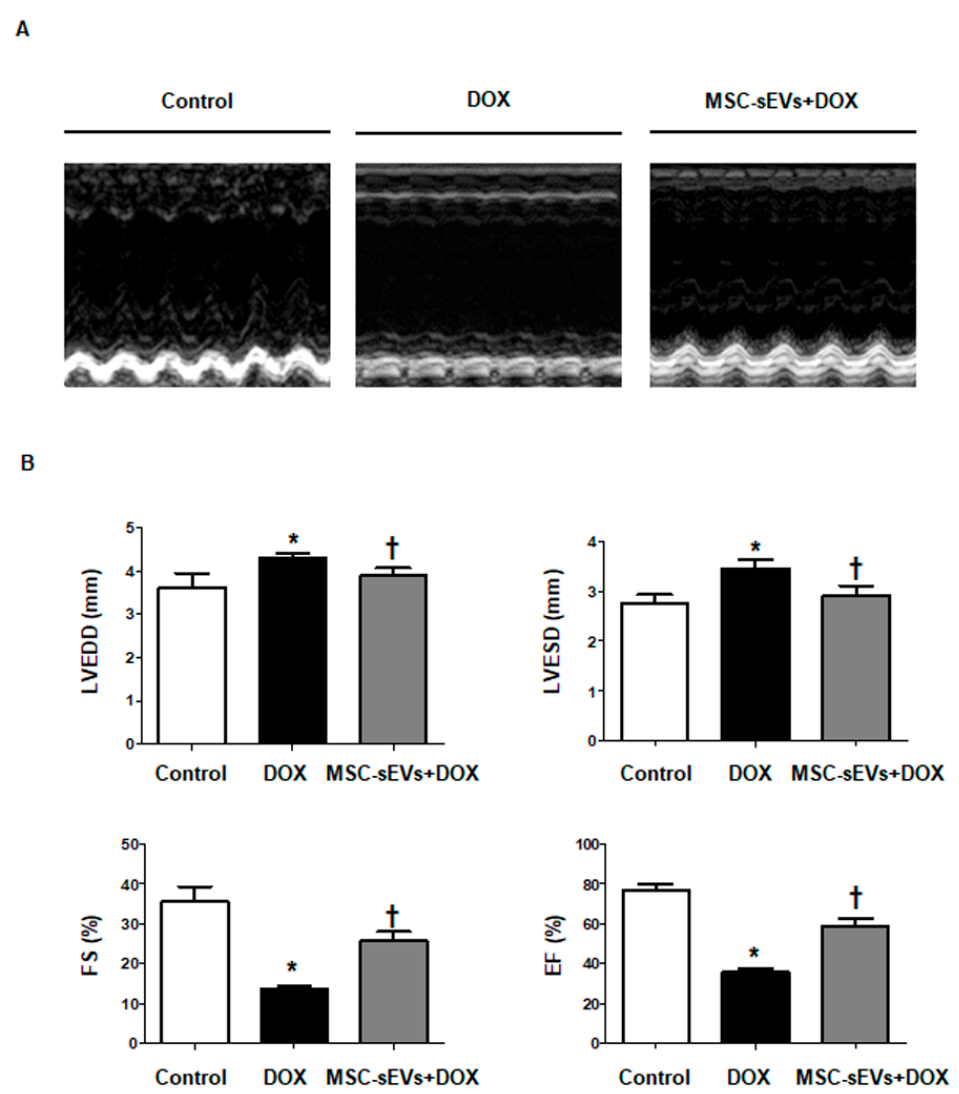
Figure 8. MSC-sEVs improves acute DOX − induced cardiomyopathy in an in vivo mouse model. ( A ) Representative M − mode images from the control, DOX, and MSC-sEVs + DOX groups. ( B ) Quantitative echocardiographic group data: LVEDD (mm), LVESD (mm), FS (%) and EF (%) ( n = 8/group). * Significant difference compared to the control ( p < 0.05). † Significant difference compared to DOX treatment ( p < 0.05).